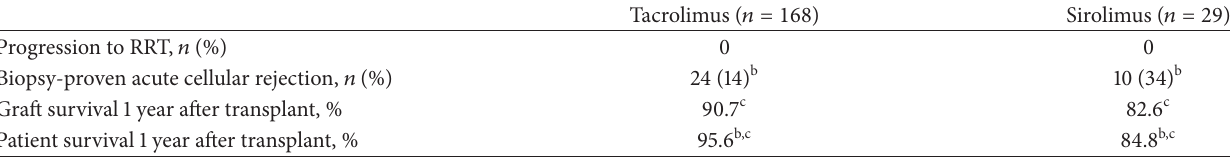
Table 2: Overall secondary